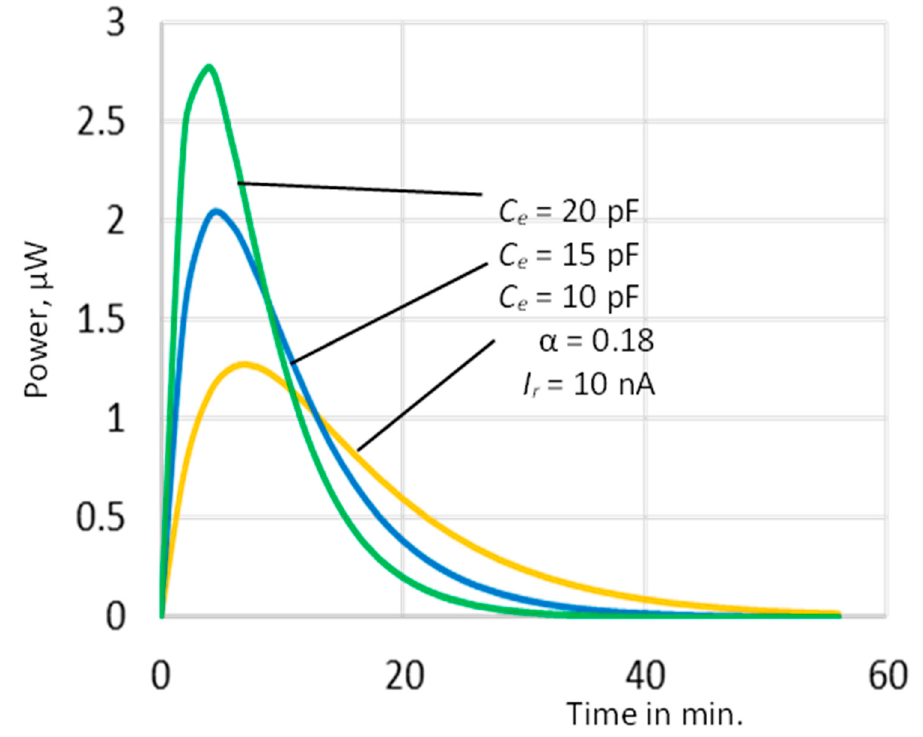
Figure 5. Power variation in Capacitor C 0 with time.